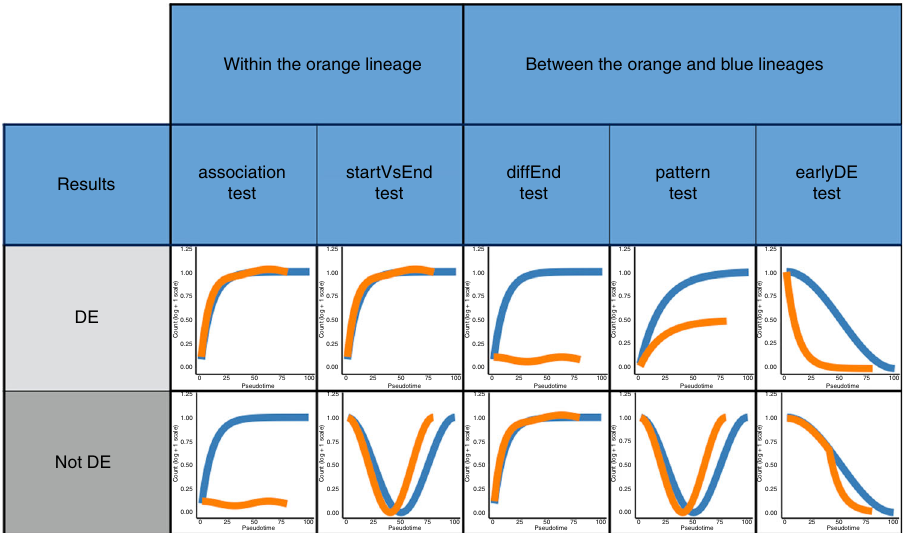
Fig. 2 Tests currently implemented in the tradeSeq package. Each column corresponds to a test. Tests are broken down into two categories, depending on whether they concern a within-lineage comparison, i.e., properties of the orange curve, or a between-lineage comparison, i.e., contrasting the blue and orange curves. For each test, we have two toy examples of gene expression patterns. The top one corresponds to a differentially expressed gene according to the test, while the bottom one does